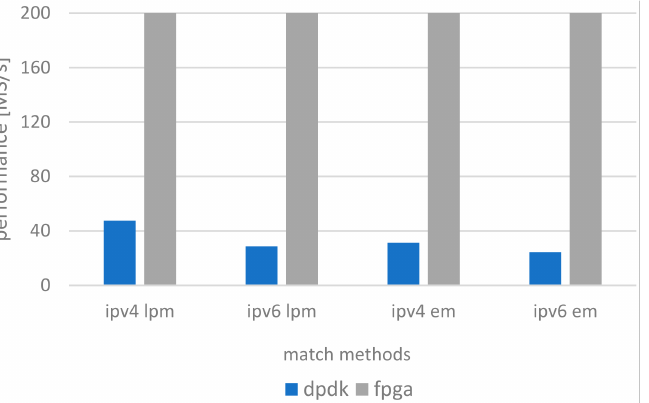
Figure 21. Comparison of the performance of software and hardware implementations of different matching algorithms.